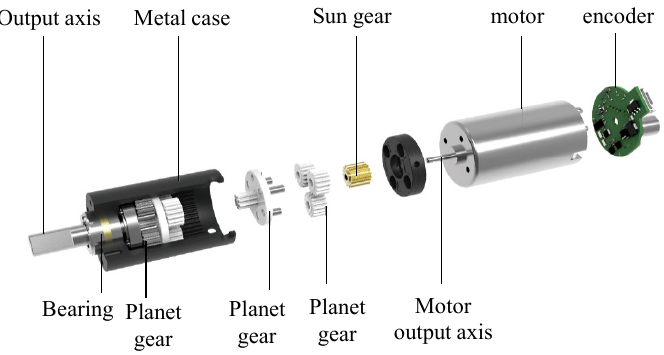
Figure 7. Appearance of three reducers.